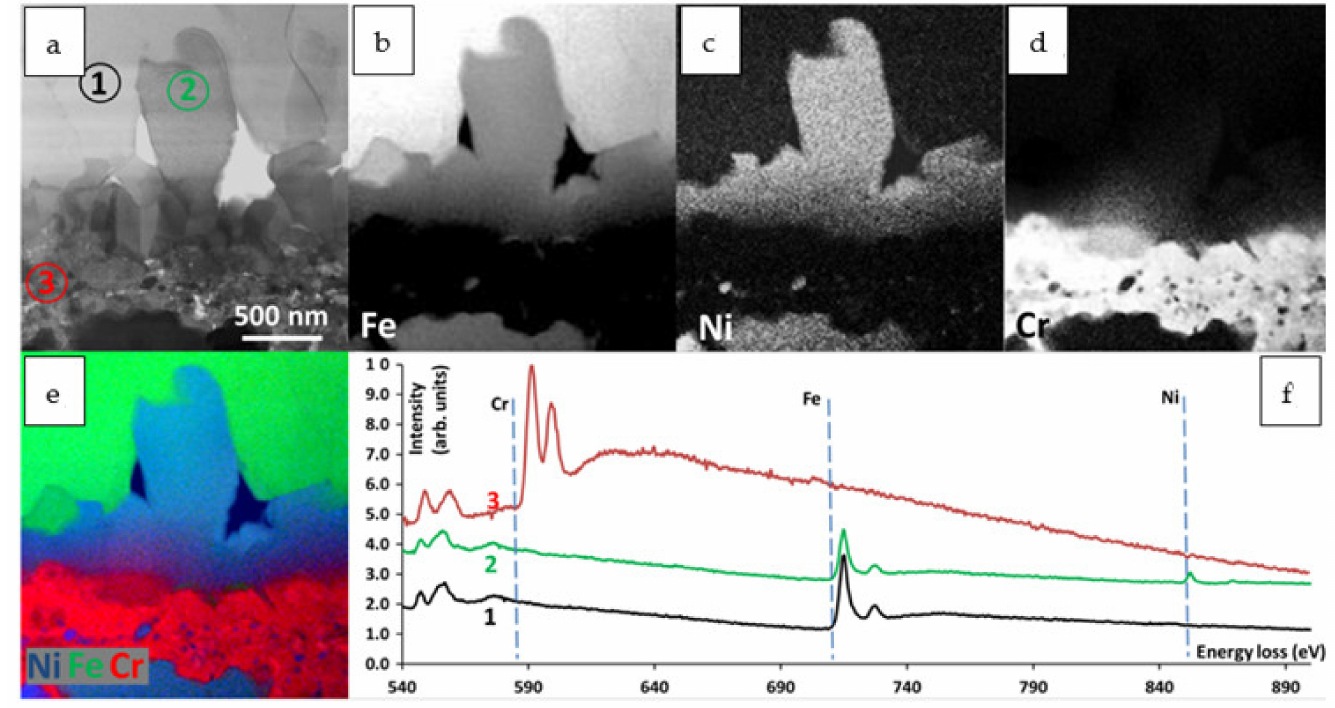
Figure 7. STEM-electron energy loss spectroscopy (EELS)-SI investigation: ( a ) region of interest (STEM-BF), ( b – d ) maps of the selected elements (EELS-SI), ( e ) compositional image of Fe, Ni and Cr, ( f ) EELS spectra for areas 1, 2, 3 (indicated in Figure